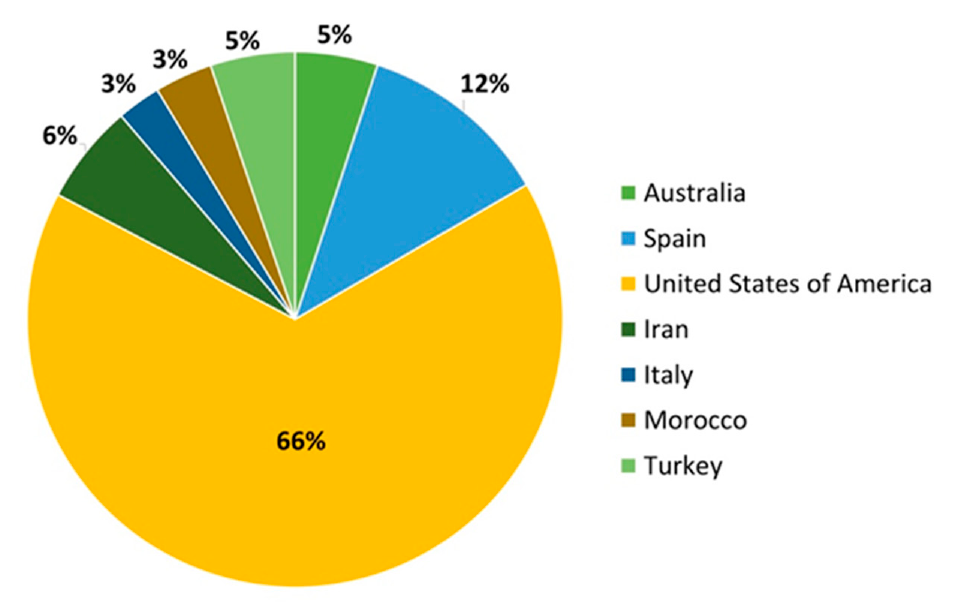
Figure 1. Worldwide almond production (2019) [2]. Table 1. Almond production by top 7 almond-producing countries [2]. Data are expressed in tonnes.